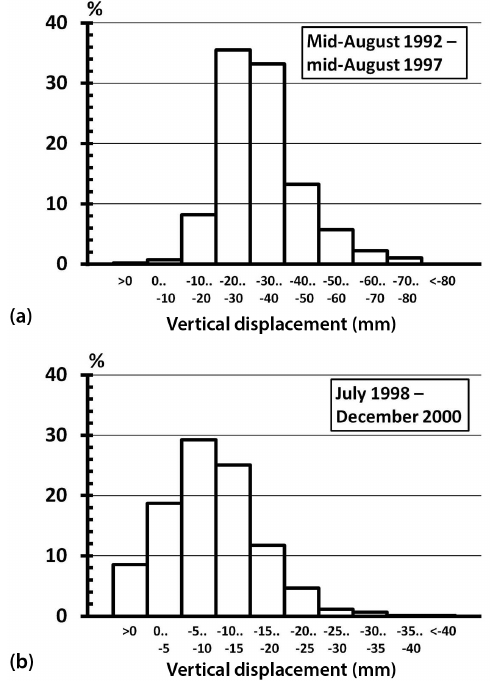
Figure 2. Distribution of total surface movement (in mm): (a) pe- riod 1, 5-year time zone, from mid-August 1992 through mid- August 1997; (b) period 1, 2.5-year time zone, from July 1998 through December 2000. Largest subsidence (negative values) is plotted to the right.